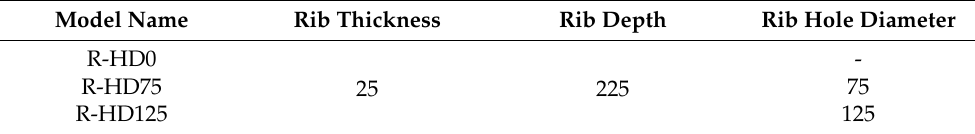
Table 2. List of finite-element models with rib plate connectors.